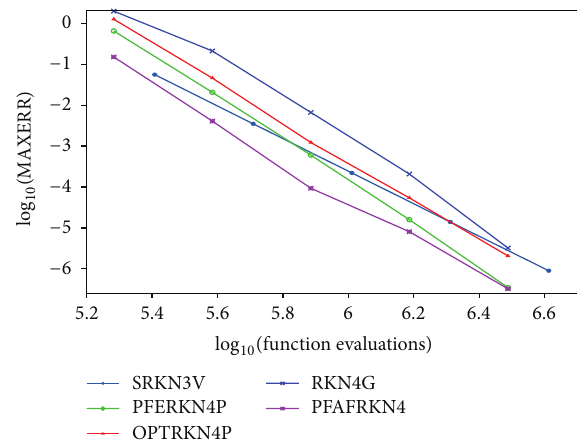
Figure 3: Efficiency curves for all methods for Problem 1 with 𝑒 = 0.2 and ℎ = 1/2 𝑖 , 𝑖 = 3, ...,7 .